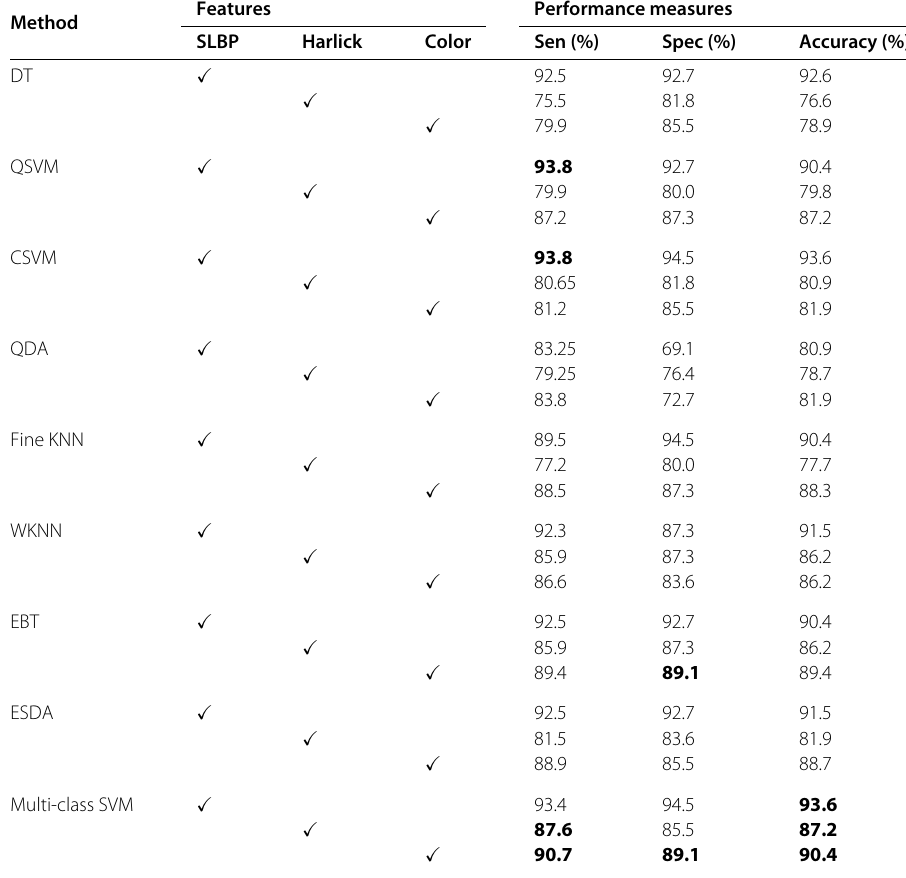
Table 8 Classification result on each extracted set of features for apple rust disease Features Method